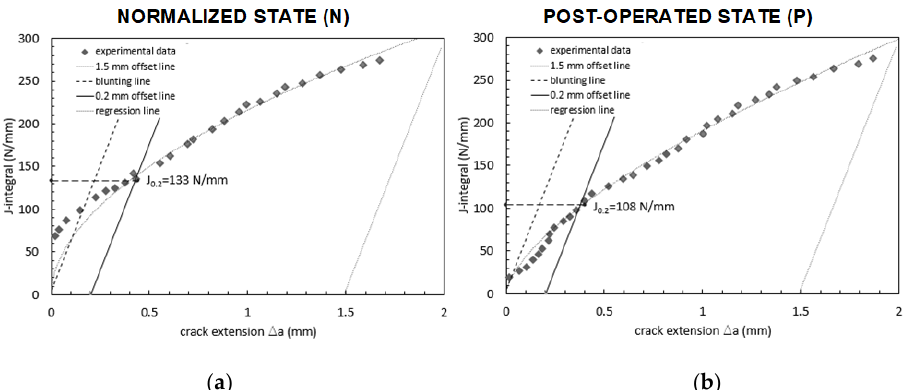
Figure 14. J-R curves for puddle iron after normalization heat treatment ( a ) and in the post-operated state ( b ).